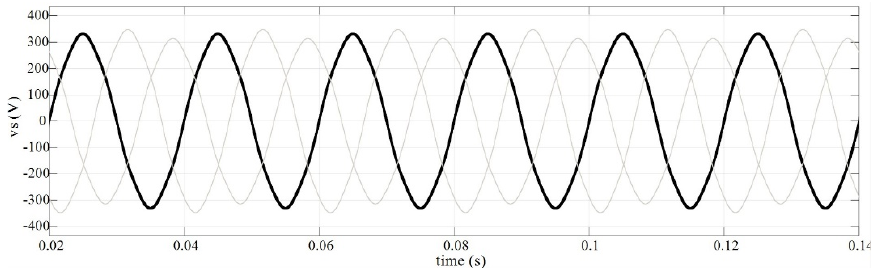
Figure 9. Voltages of a distorted and unbalanced 3-phase system; phase 1 is highlighted.